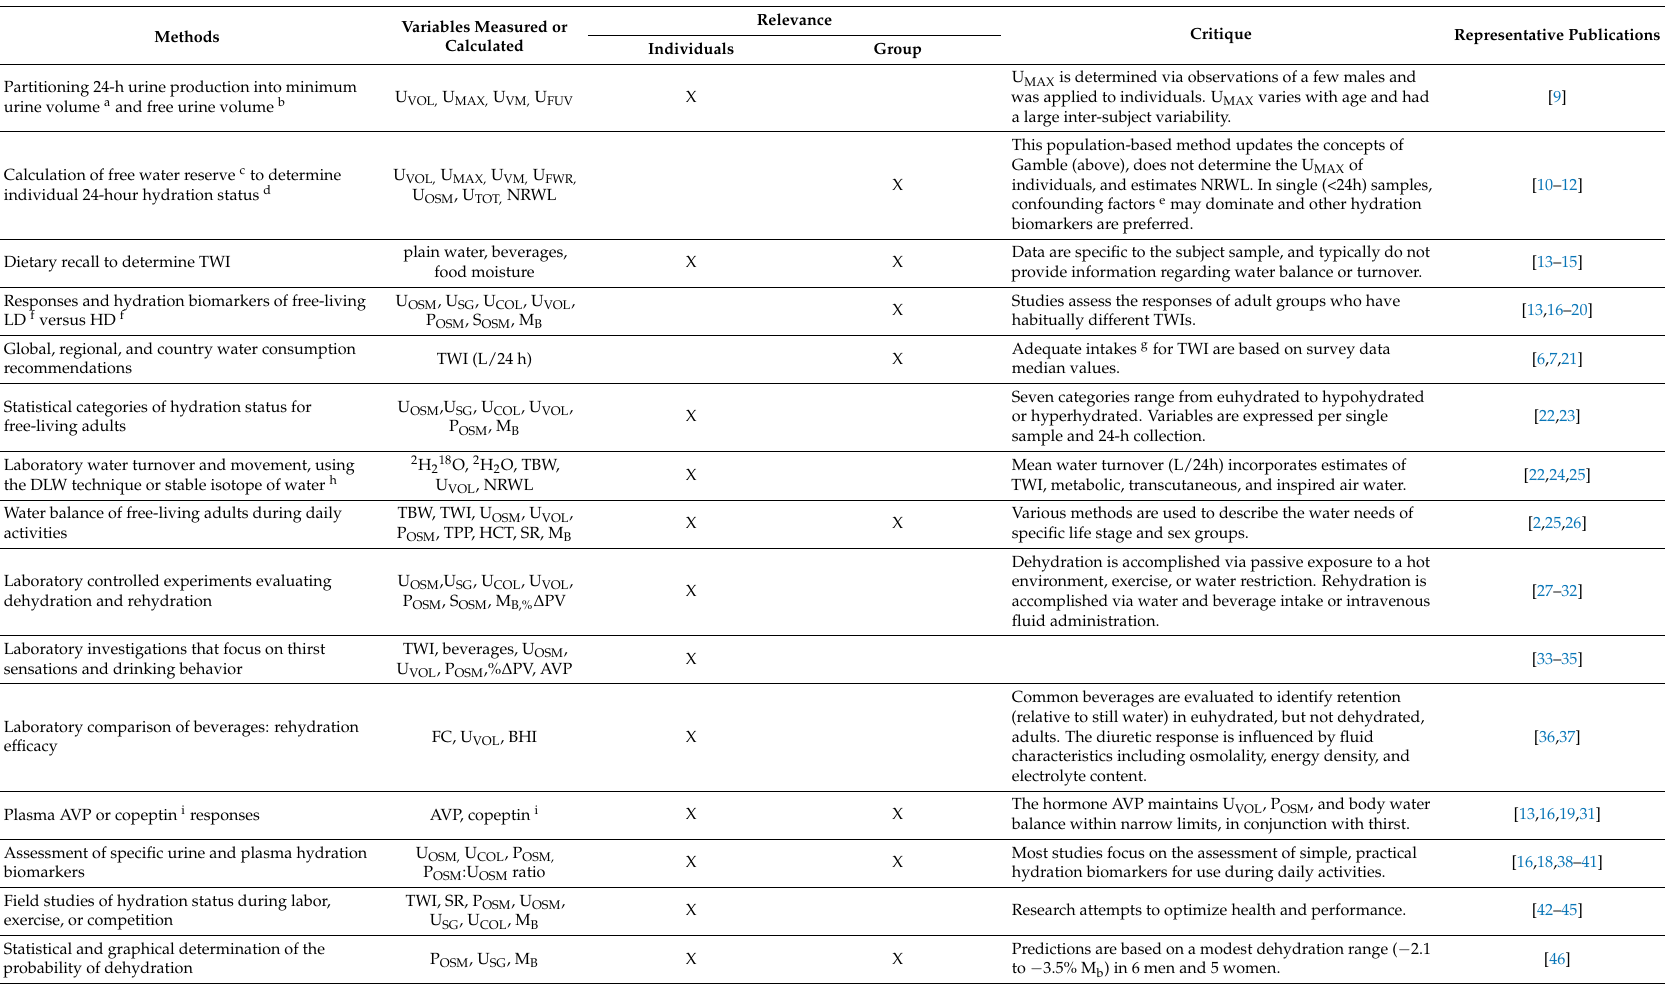
Table 2. Investigational and theoretical approaches to assess human water intake, euhydration, hypohydration, and water